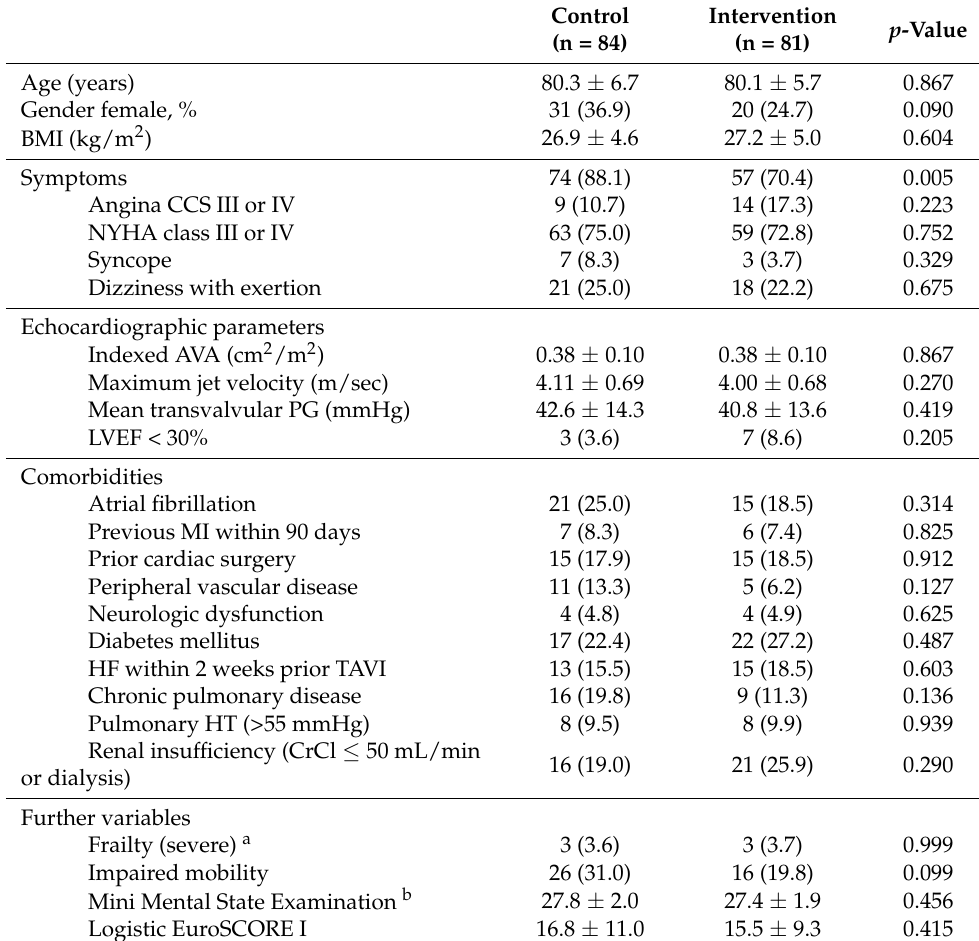
Table 2. Patient characteristics prior to (control phase) and after implementation of the TAVI coordi- nator (intervention